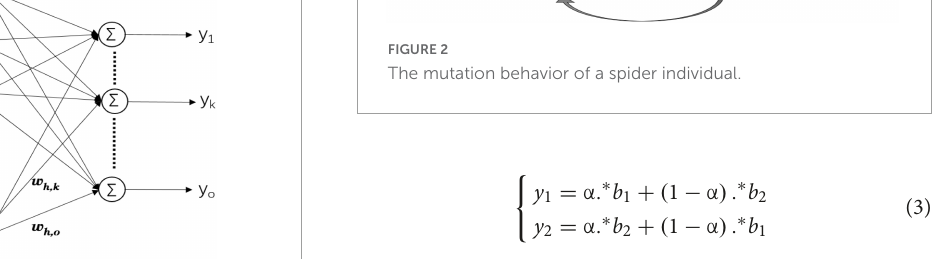
FIGURE2 The mutation behavior of a spider